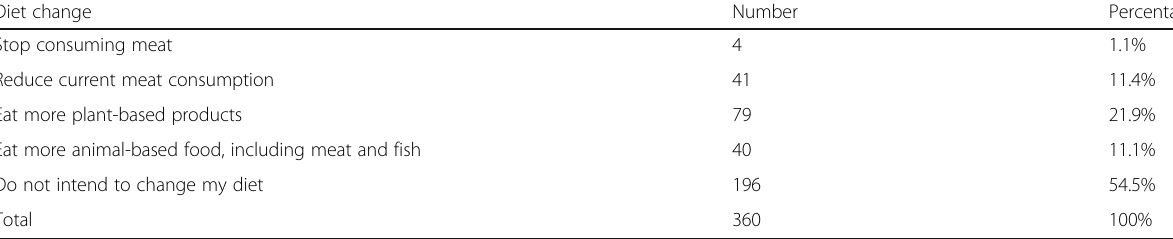
Table 7 Diet change intentions of people consuming meat: 2018 Sydney responses Diet change Stop consuming meat Reduce current meat consumption Eat more plant-based